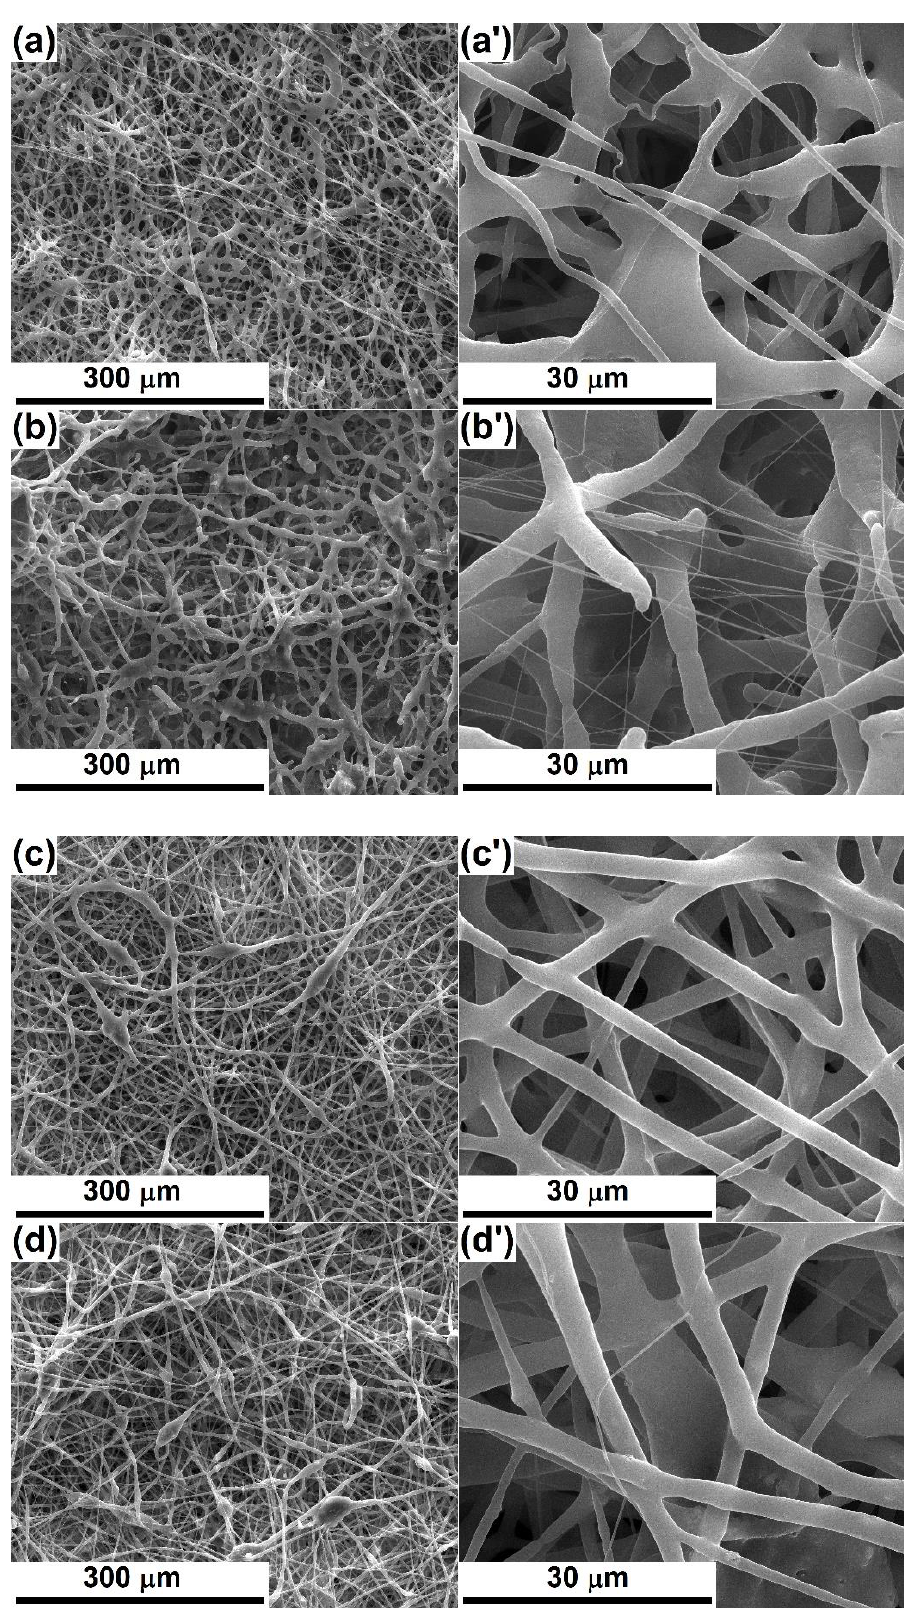
Figure 2. SEM images, based on secondary electrons at different magnifications, of: ( a , a' ) PCL-Mg-1, ( b , b' ) PCL-Mg-5, ( c,c' ) PCL-Sr-1 and ( d , d' ) PCL-Sr-5 scaffolds.